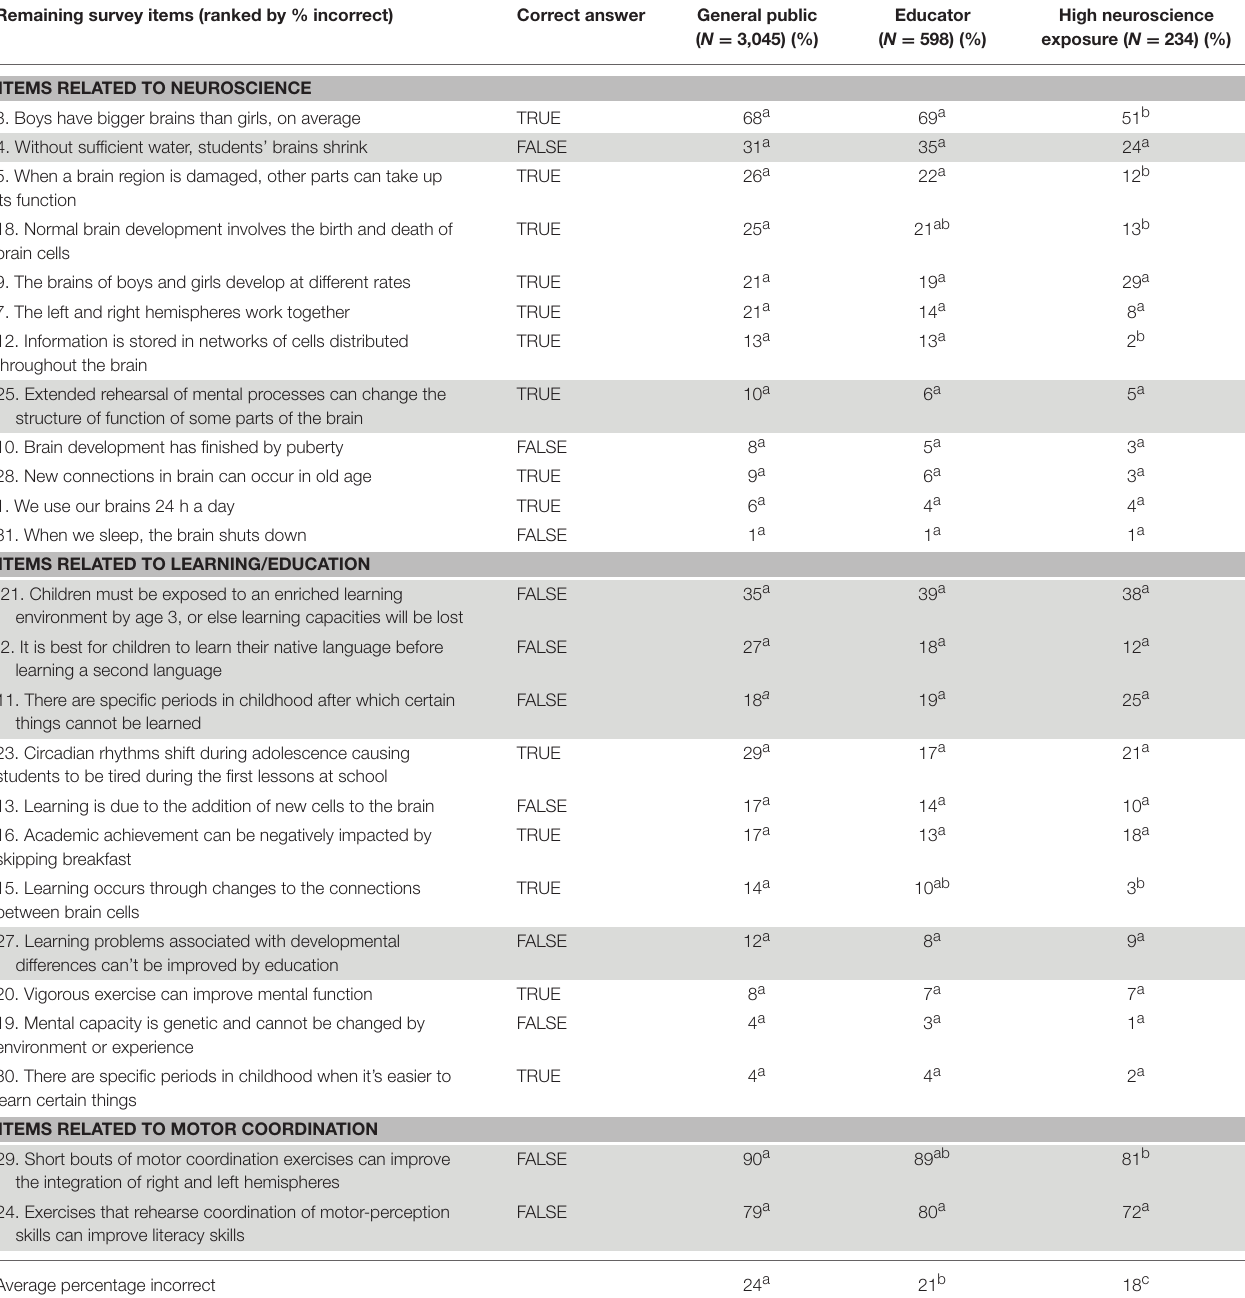
TABLE 6 | Accuracy on remaining survey